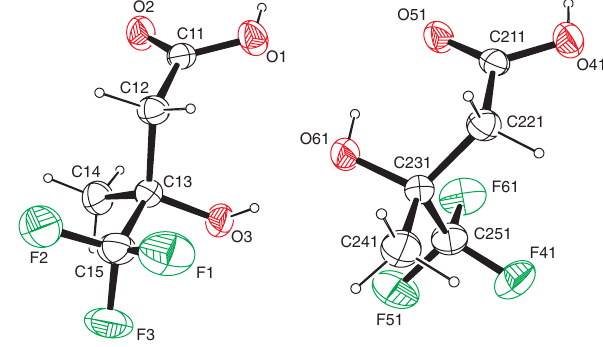
Table 1: Data collection and handling.